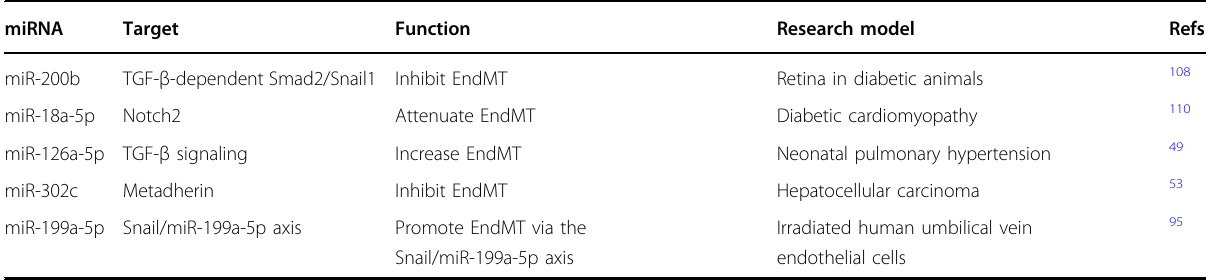
Table 1 The effects of miRNAs on